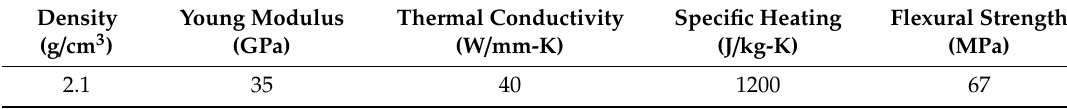
Figure 2. The tensile stress value according to temperature of C / SiC composite. Table 1. Mechanical properties of C / SiC